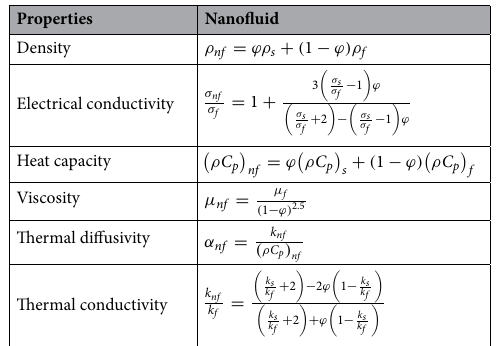
Table 1. The thermophysical properties of nanofluid.